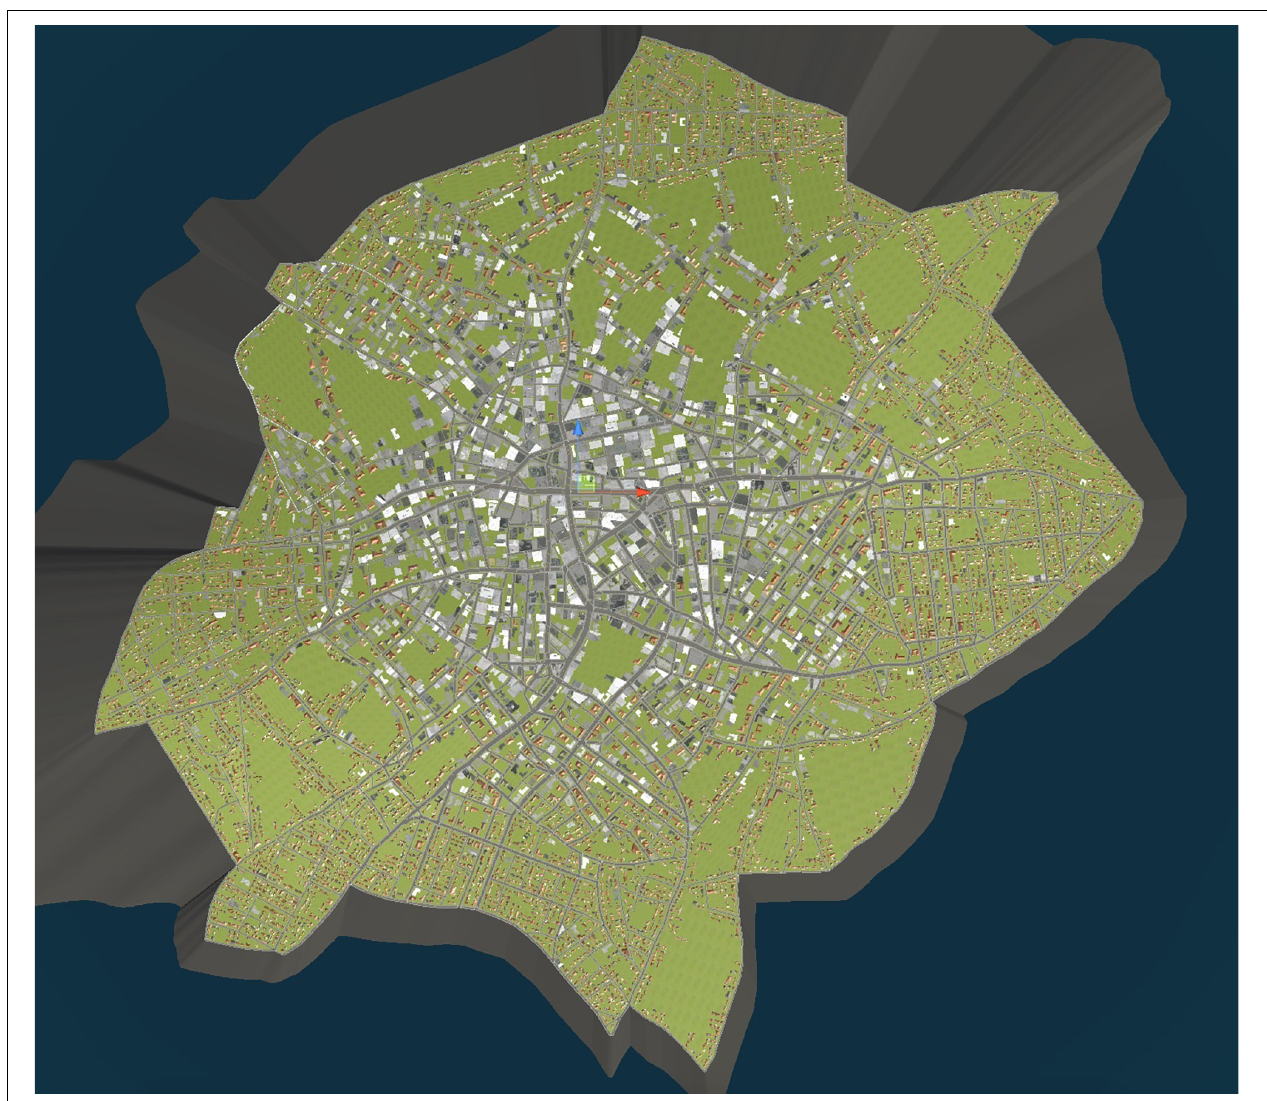
FIGURE 1 | Overhead view of the city